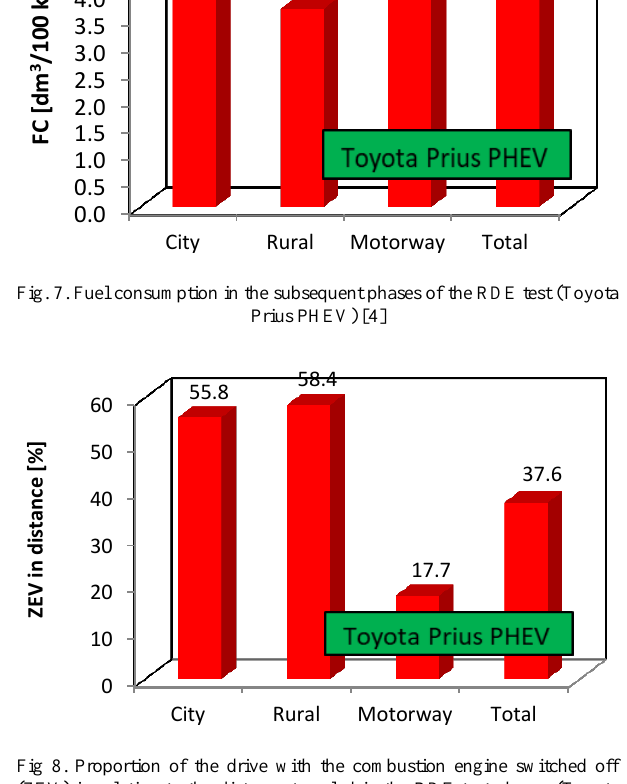
Fig 8. Proportion of the drive with the combustion engine switched off (ZEV) in relation to the distance traveled in the RDE test phases (Toyota Prius PHEV) [4]